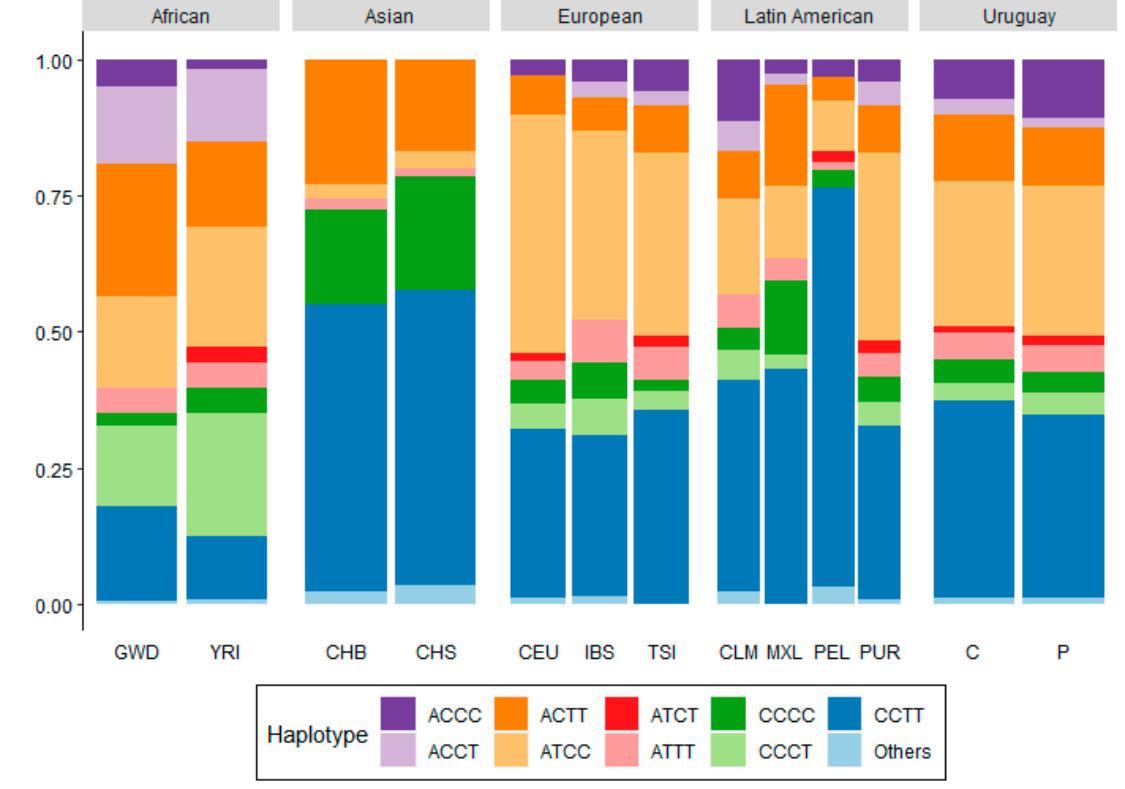
Figure 1. Haplotype frequencies of VDR SNPs for Uruguayan, Latin American, African, European, and Asian populations. P: patients, C: controls, CEU Utah Residents (CEPH), CHB: Chinese from